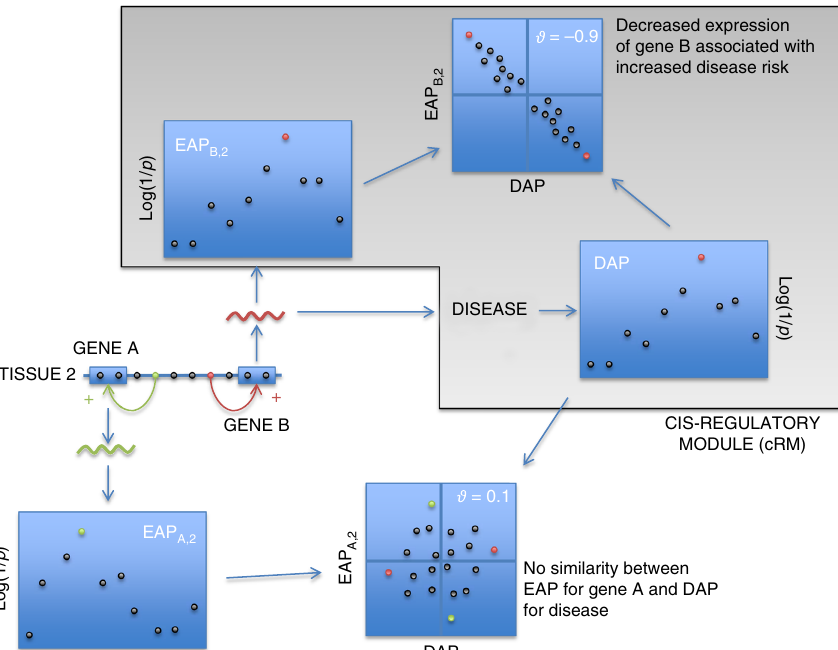
Fig. 6 DAP-matching cRM. If a regulatory variant (red) affects disease risk by altering the expression levels of gene B in tissue 2, the EAP B,2 is expected to be similar (high | ϑ |) to the “ disease association pattern ” (DAP), both assigned therefore to the same cRM. ϑ is positive if increased gene expression is associated with increased disease risk, negative otherwise. A cis -eQTL that is driven by a regulatory variant (green) that does not directly affect disease risk, will be characterized by an EAP (say gene A, tissue 2, EAP A,2 ) that is not similar to the DAP (low | ϑ